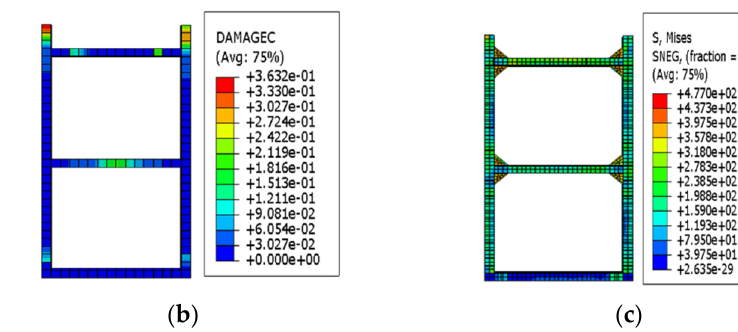
Figure 8. Stress contour plots at a drift ratio of 1/130. ( a ) Stress contour plot of the wall concrete; ( b ) stress contour plot of the concrete cast in the steel tubular columns; and ( c ) von Mises stress contour plot of the steel tubular columns.